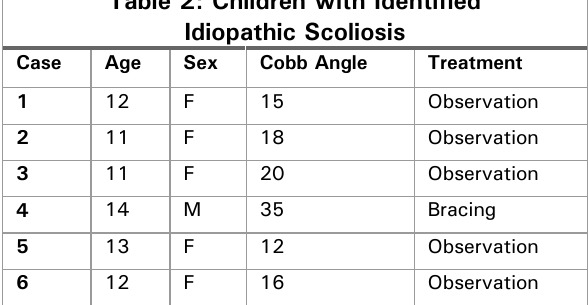
Table 2: Children with Identified Idiopathic